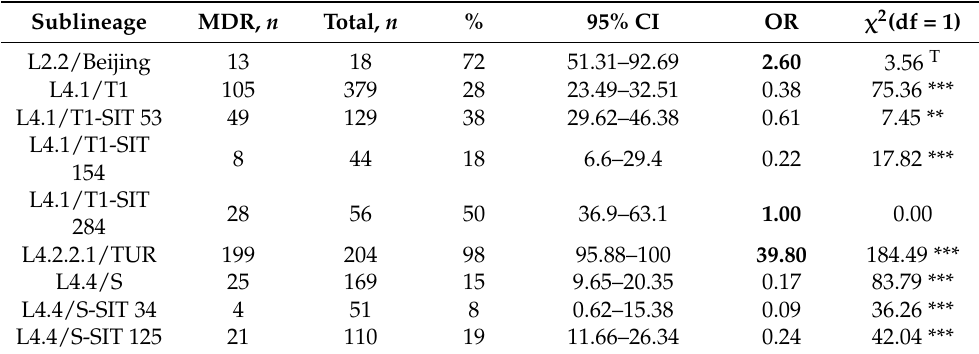
Table 2. Probability for multidrug resistance of dominant sublineages in Bulgaria for the period 2008–2018. OR ≥ 1 is in bold. MDR,